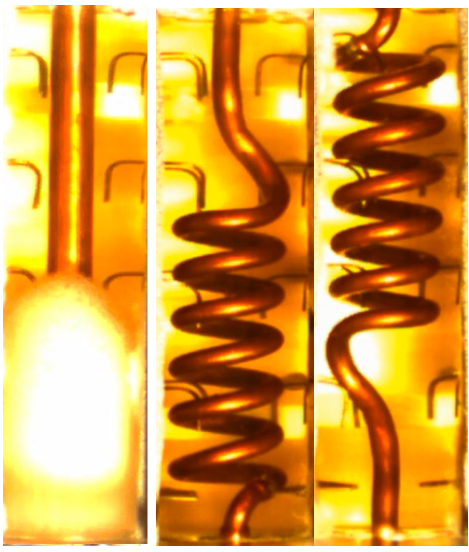
Figure 20. Melting front images for different geometry of storage units but for the same process time equal to 110 min and the same constant wall temperature condition ( Ts = 34 °C): at left for annular TES, at the middle for shell-and-coil TES with coil position at the bottom of the tank, at the right for shell-and-coil TES with coil position at upper of the tank .